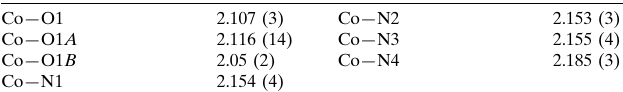
Selected bond lengths (A˚ ).